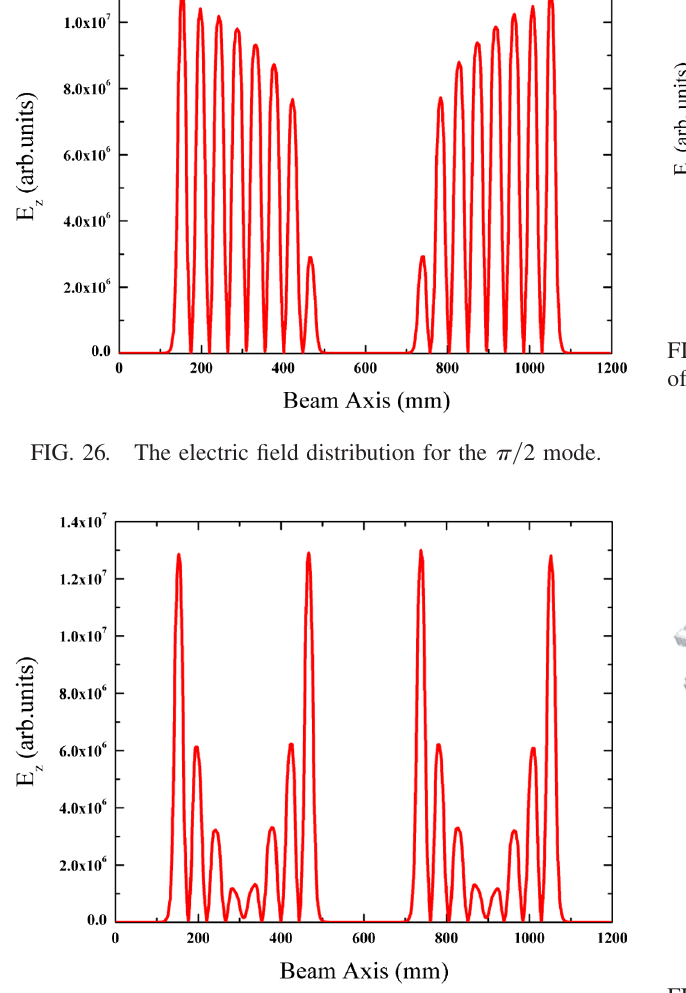
FIG. 27. The electric field distribution for the coupled (cid:3) mode.